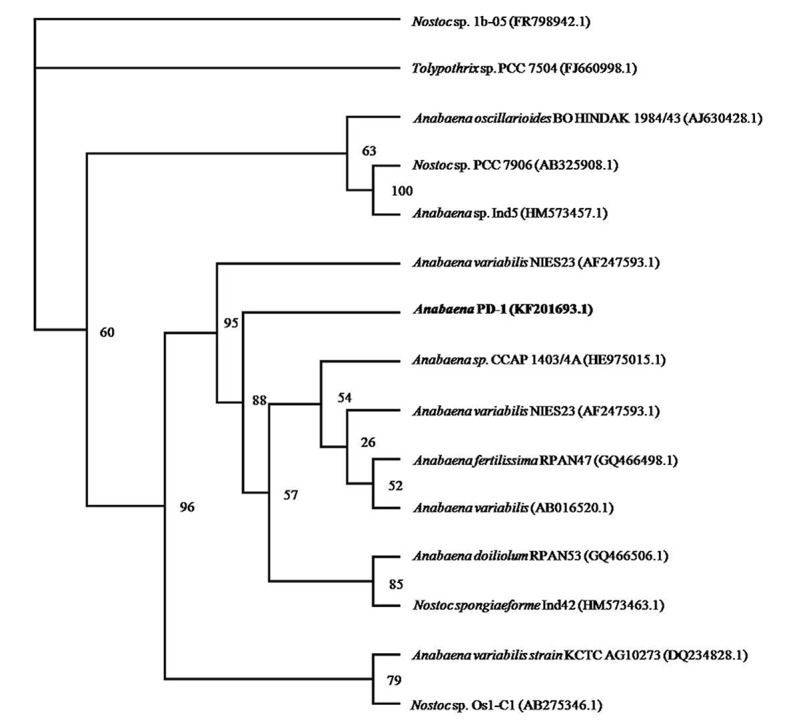
Phylogenetic tree based on an alignment of the sequences of the 16s rDNA of cyanobacterium Anabaena PD-1, which was generated using PAUP.The cyanobacterial strain obtained and the accession number in this study are shown in bold.